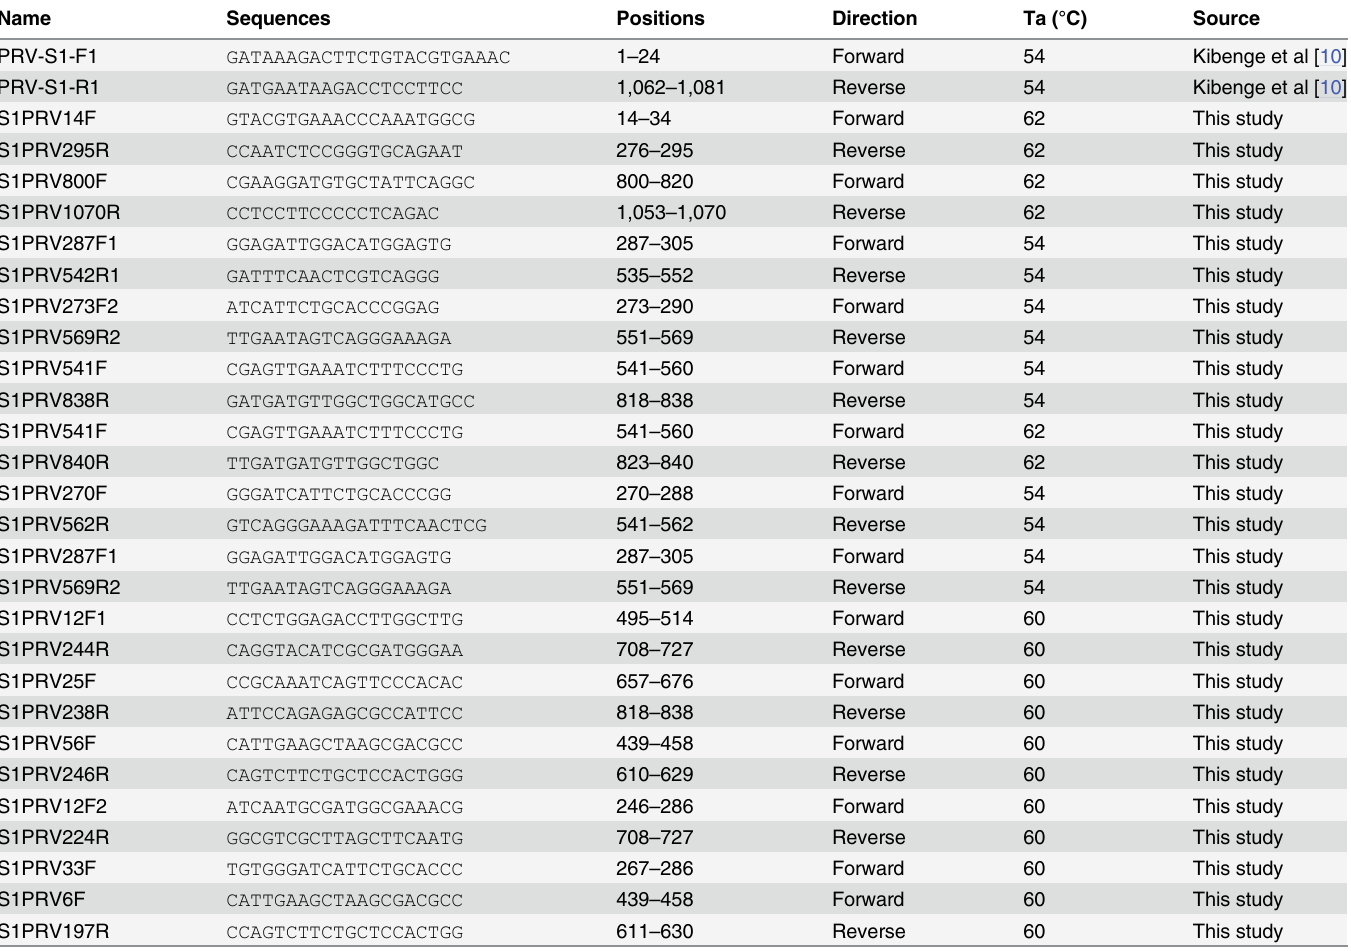
Table 1. Primer sequences used for Reverse Transcriptase — Polymerase Chain Reaction and sequencing of partial segment S1 of piscine reovi- rus. Ta is the annealing temperature used for each set of